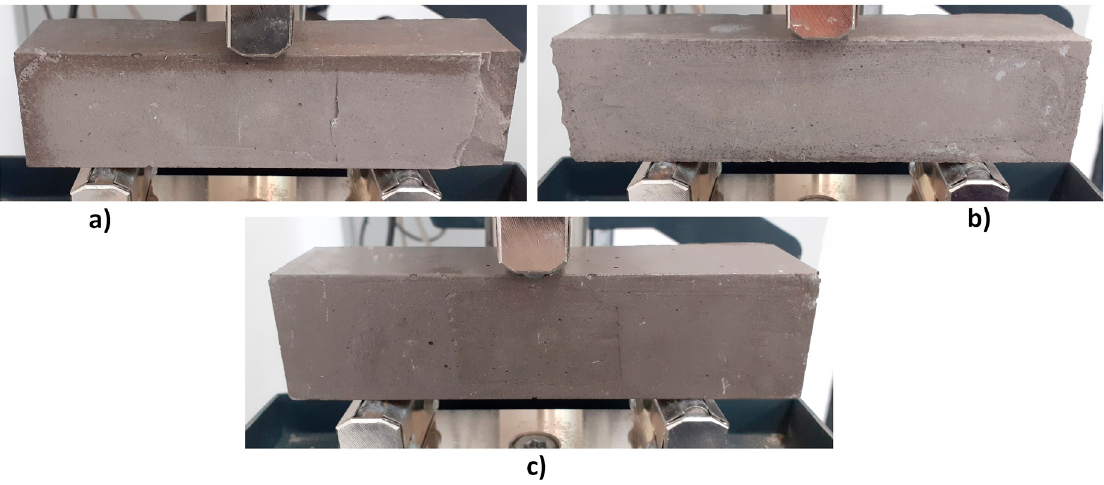
Figure 6. Ready to three-point bending test samples made of mixture FBC FA + M (25%) demolded after: ( a ) 7 days; ( b ) 14 days; ( c ) 28 days.